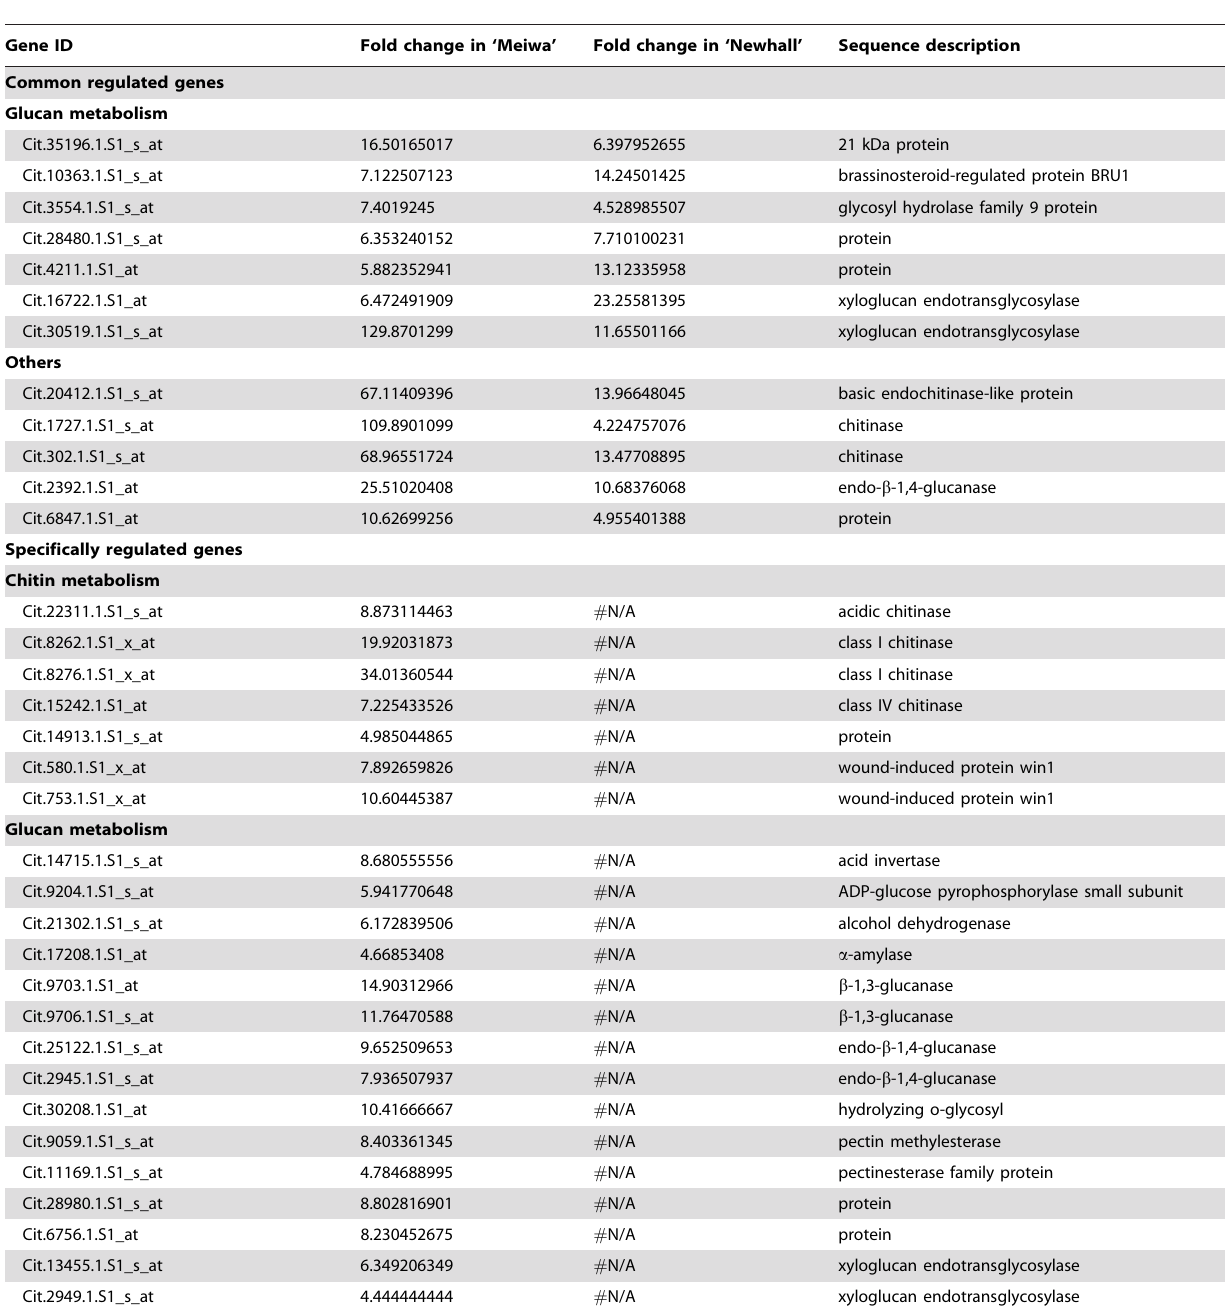
Table 5. Significantly enriched genes involved in polysaccharide metabolism that are regulated in common between ‘Meiwa’ and ‘Newhall’ or specifically regulated in